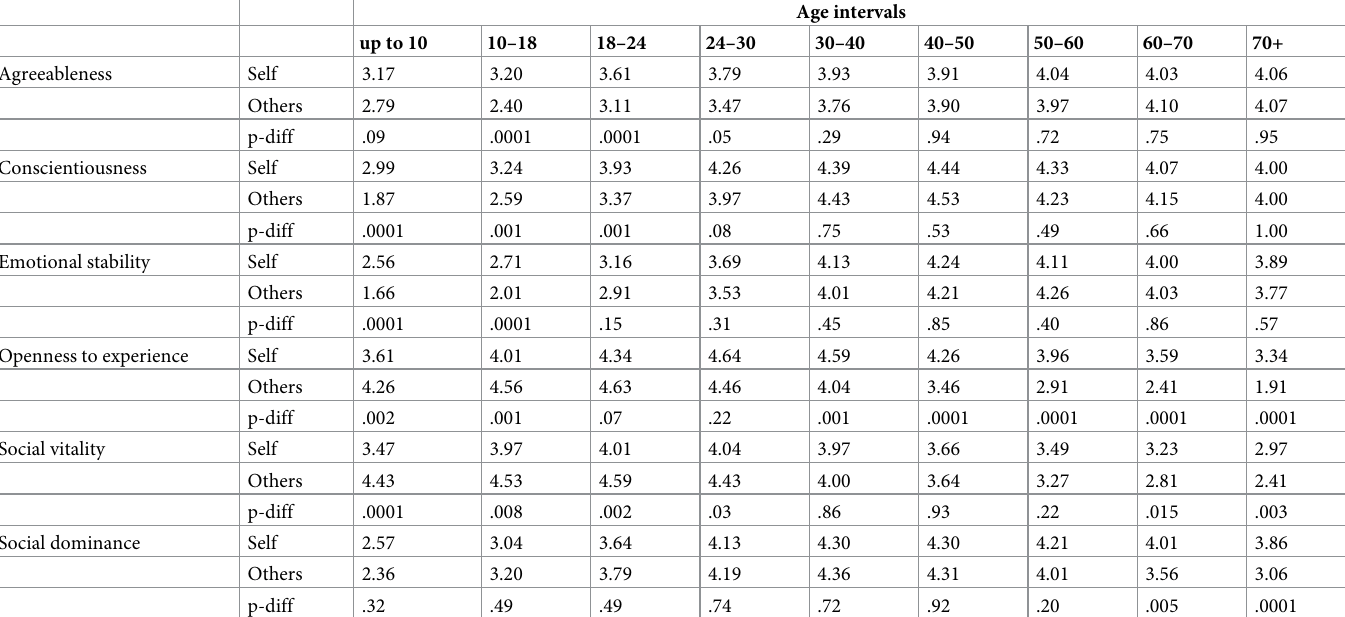
Table 6. Means ratings for FFM traits at each age interval for the self and others with post hoc analyses for mean